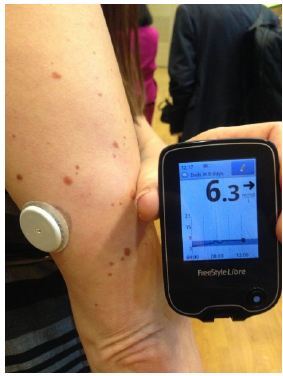
Figure 8. The Abbott FreeStyle Libre Flash Glucose Monitoring System (available online: http://diatribe.org/issues/69/new ‐ now ‐ next/1, accessed on 3 December 2015).